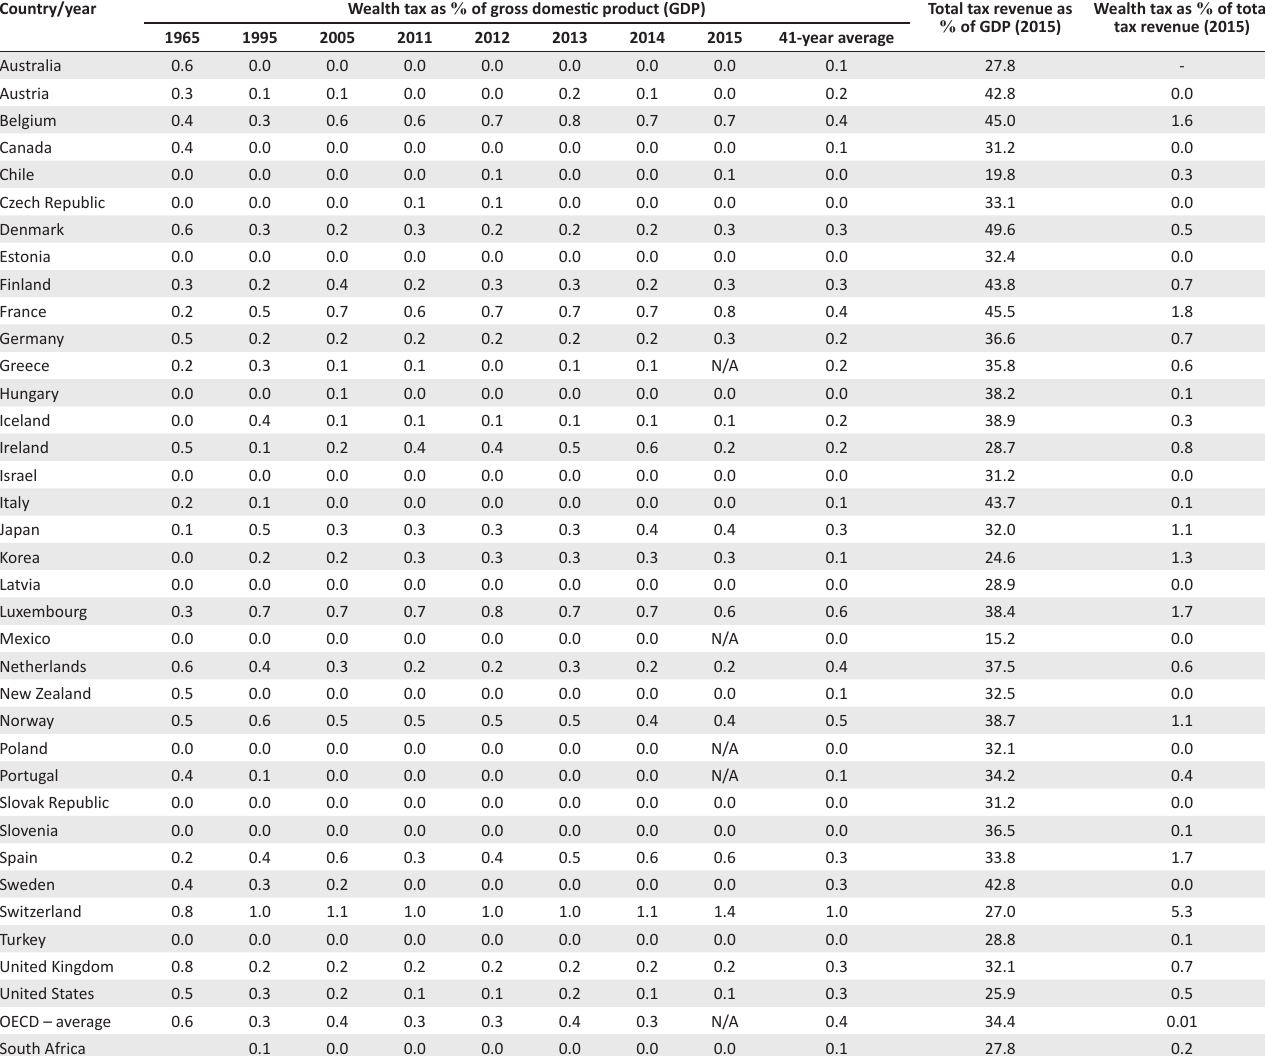
TABLE 2: Wealth tax in Organisation for Economic Co-operation and Development countries and South Africa.